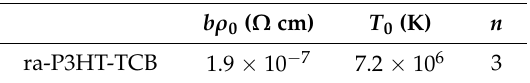
Table 2. Fitted values of a ρ m , b ρ 0 , n and T 0 in Equation (1) by using measured resistivity